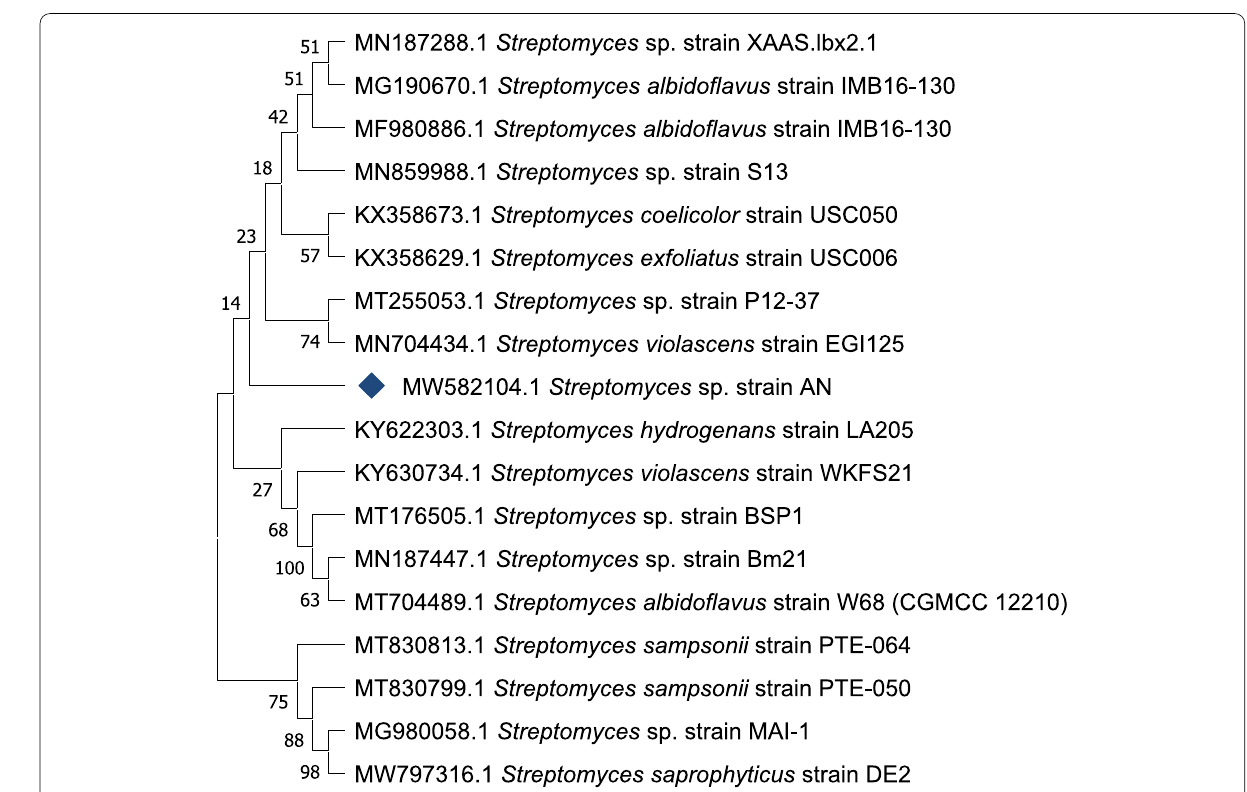
Fig. 2 A phylogenetic tree, based on the 16S rRNA gene sequence comparison showing the position of Streptomyces sp. strain AN, and its closest